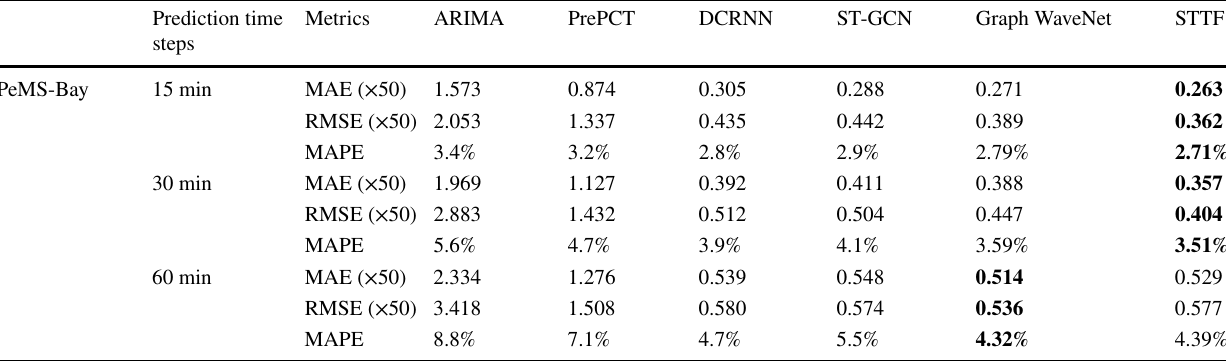
Table 2 Performance of each model in PeMS-BAY database under different prediction time step (predictions are made every 30 minutes and the optimal values under the same time step are